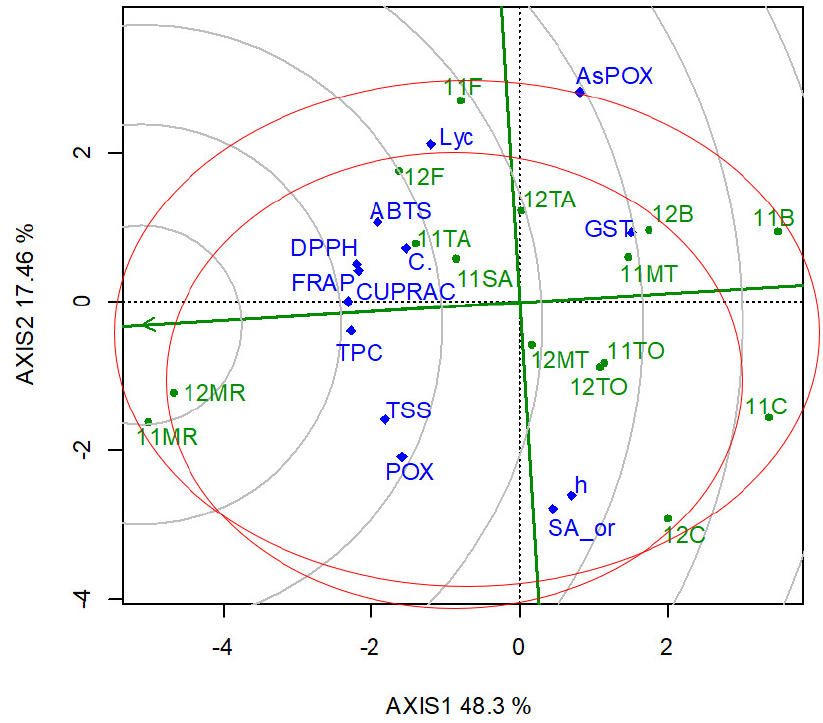
Figure 3. Genotype-focused GGE biplot based on the phytonutrient dataset of the investigated tomato PGRs in 2015. Red oval circles divide datapoints of locations. Legend: green data points, first